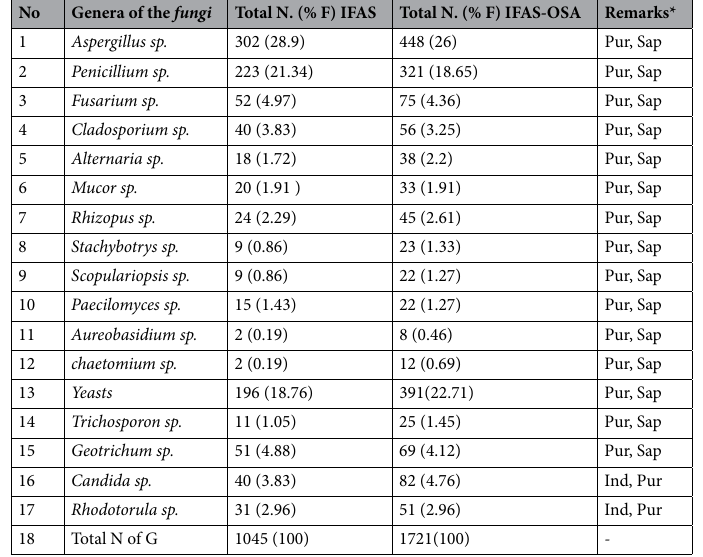
Table 7. Distribution of the total number (CFU/ml) and percentage frequency (%F) of various fungal genera and species in the IFAS and IFAS-OSA systems. Sites of sampling: I- anoxic tank, II- aeration tank, III- clarifier tank, IV- anoxic sludge holding tank (ASHT), V- effluent tank. N: Number, G: Genera, S: Species. *Pur: Purifying; Sap: Saprophytic; Ind: